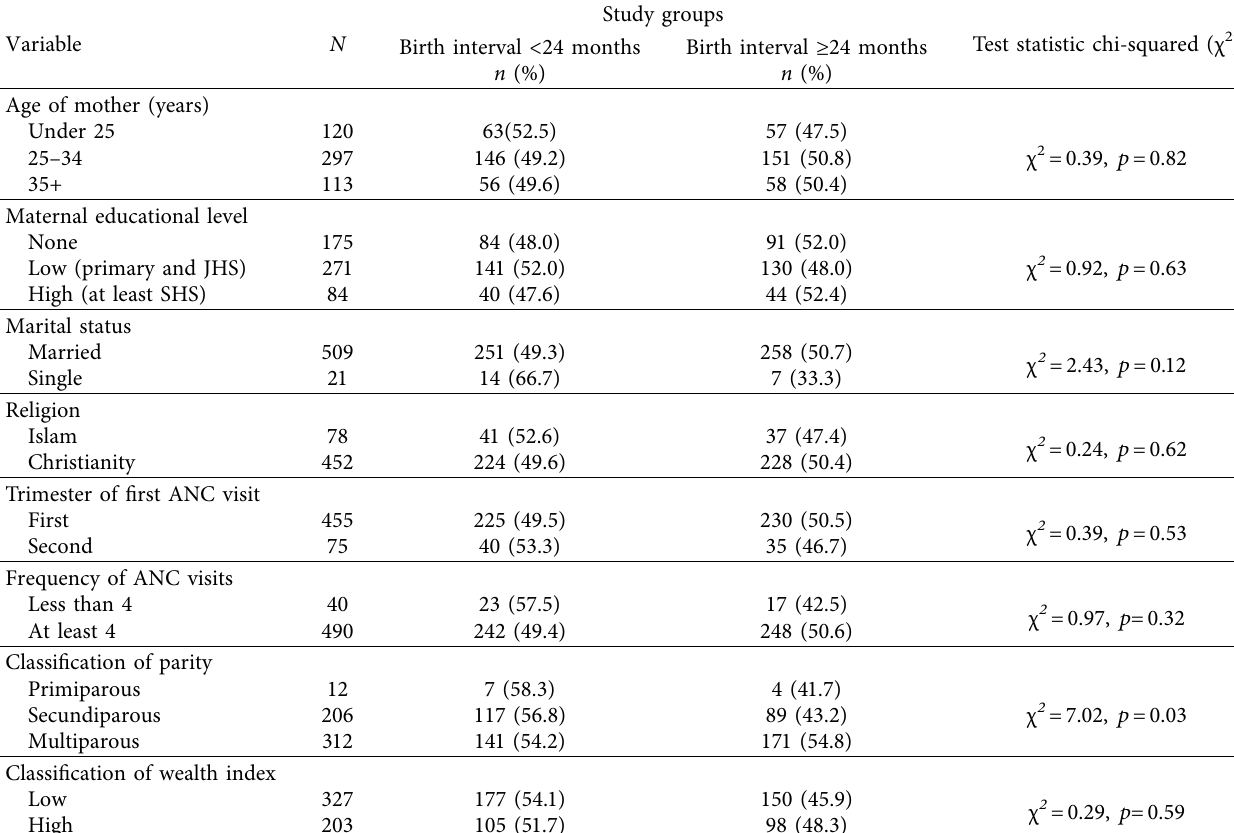
Table 1: Comparison of sociodemographic characteristics by study groups ( N � 530).